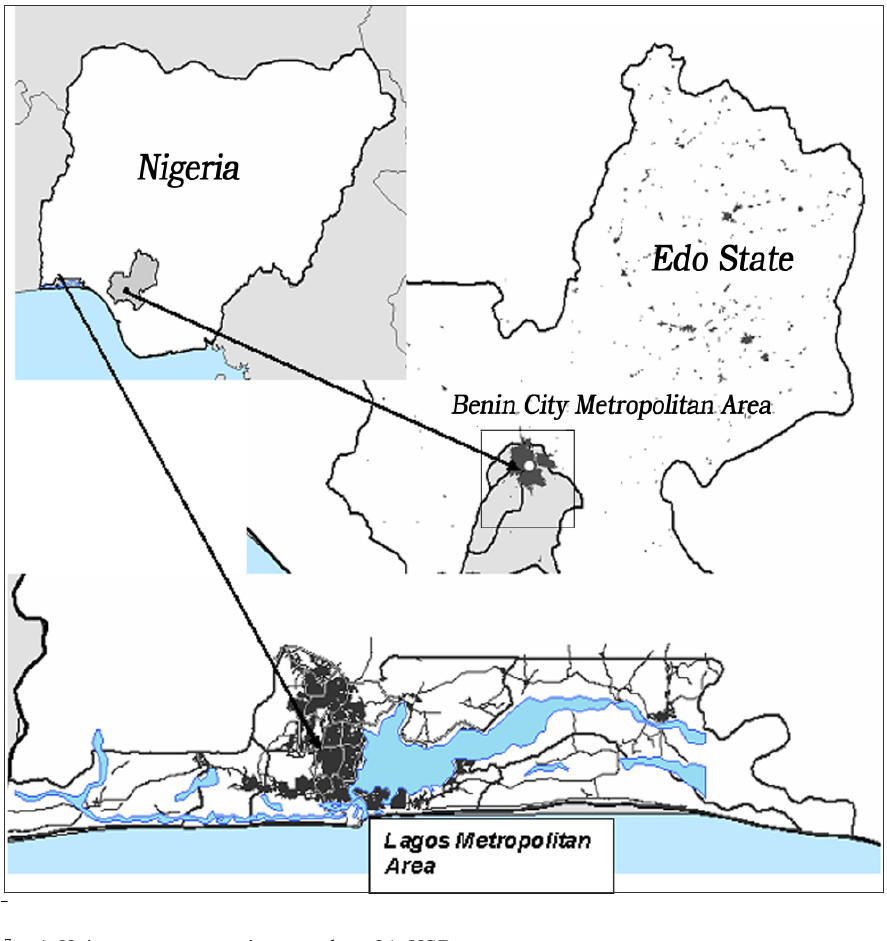
Figure1. Area of Study. Source: Maps by Charisma Acey, 2008. Data Source: 3dTechnologies, ESR